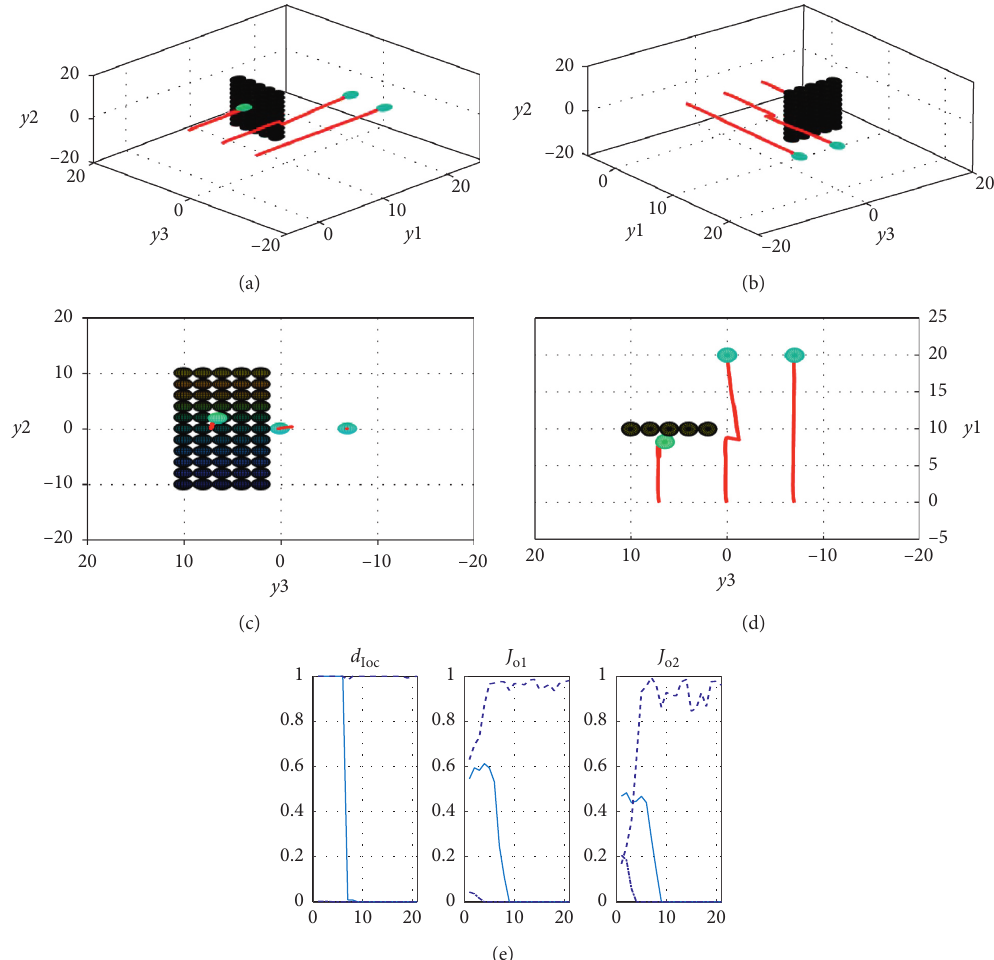
Figure 34: Case 1 simulation results. (a–d) Results of simulating the movement of a group of AMR when reaching the endpoint; (e) estimation of the complexity of the environment during